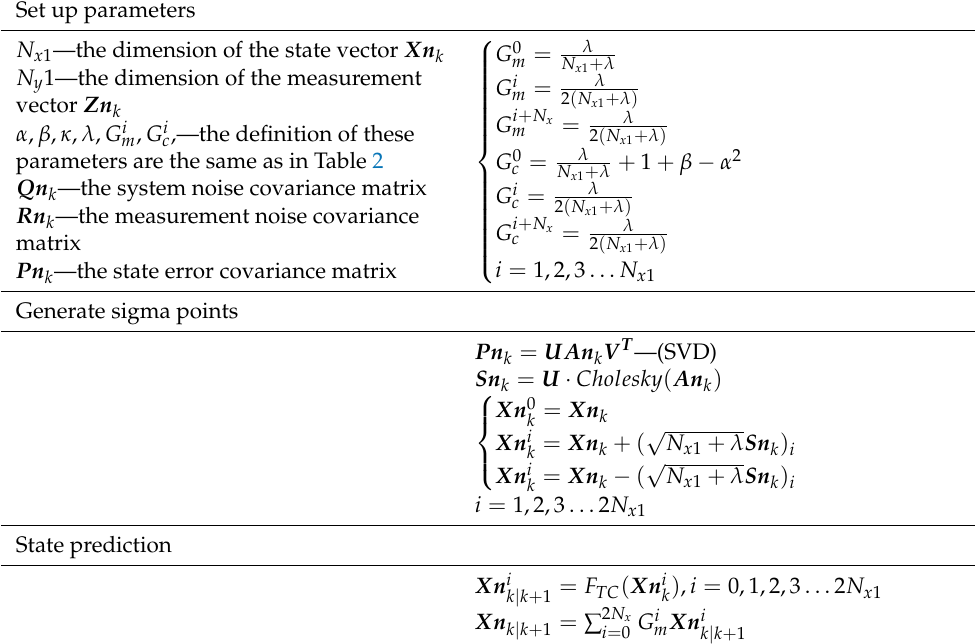
Table 3. The process of UKF in tightly coupled